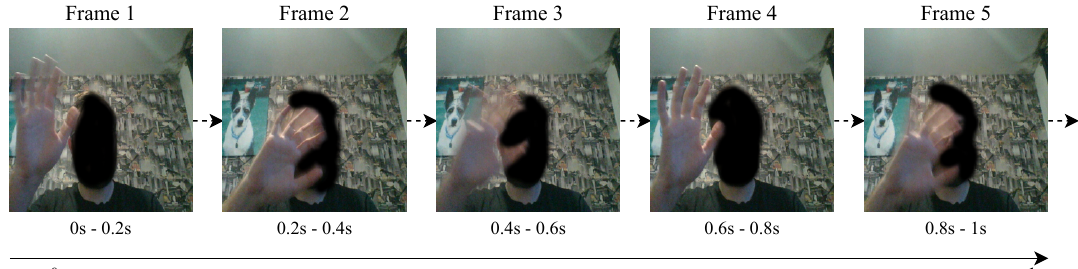
Figure 3. An overall diagram of the three benchmarking experiments. Above shows the process of image classification and below shows Leap Motion data classification for the same problem of sign language recognition. The higher order function network shows the late fusion of the two to form a multimodality solution.